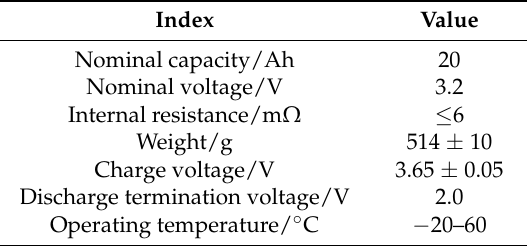
Table 2. Basic parameters of the lithium iron phosphate